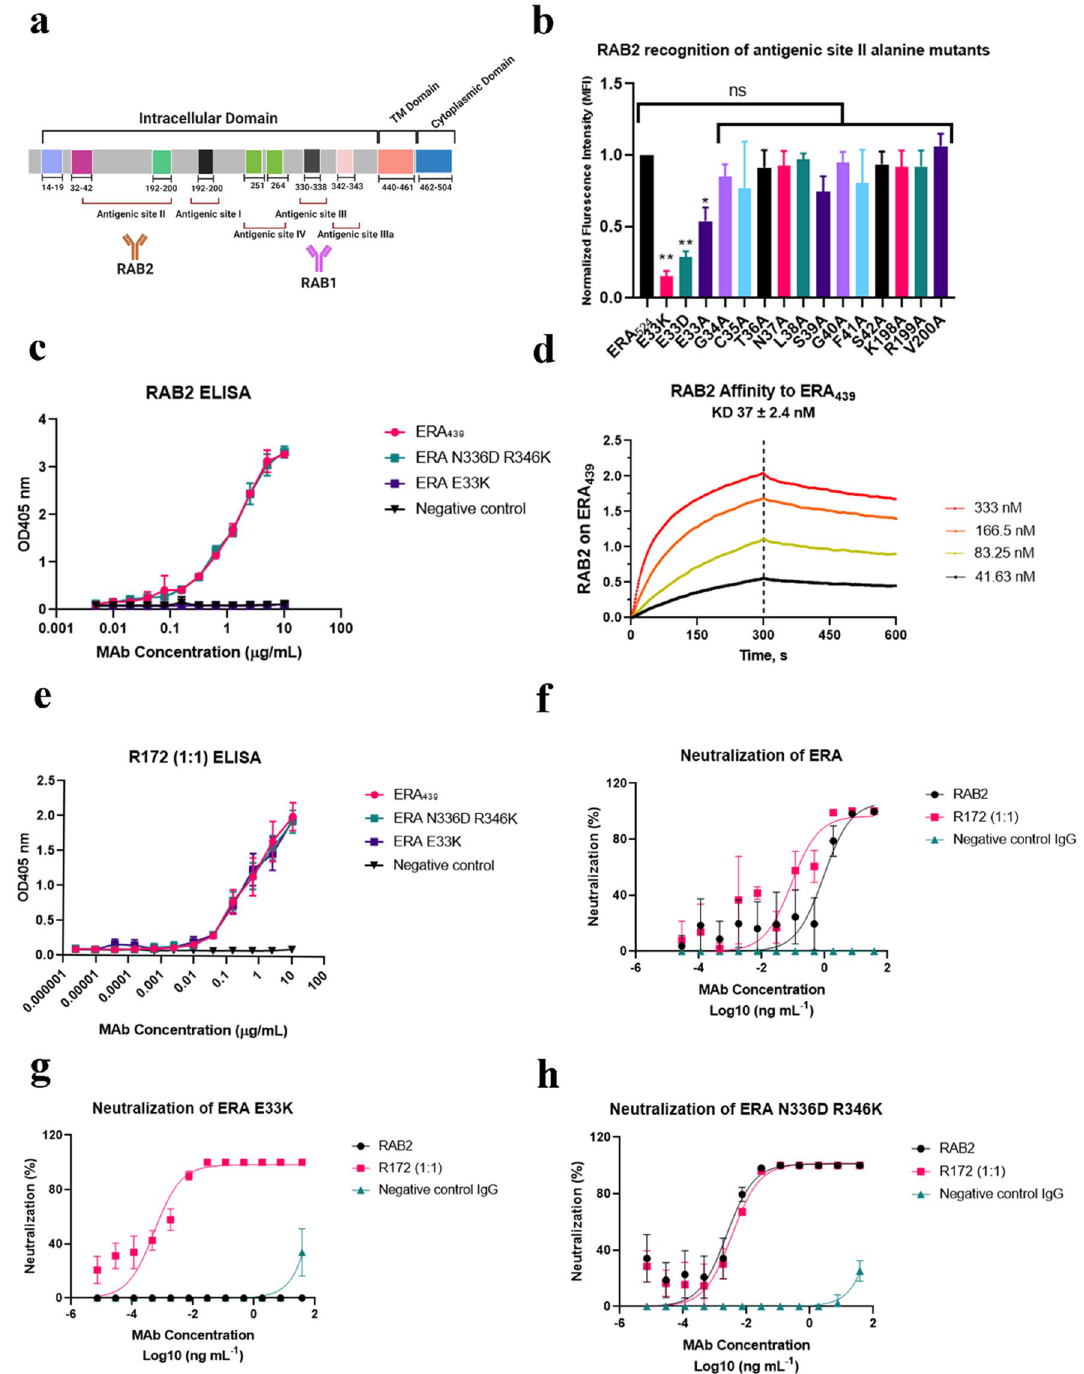
Figure 1. RAB2 and R172 binding and neutralization of rabies glycoproteins. ( a ) Schematic of rabies glycoprotein showing non-overlapping antigenic site locations of RAB1 (antigenic site III) and RAB2 (antigenic site II), figure was created with BioRender.com. ( b ) RAB2 recognition of antigenic site II alanine mutants. Each amino acid in the antigenic site II of ERA full length surface glycoprotein (a.a. 1–524) was substituted with alanine by site directed mutagenesis. ( c ) ELISA binding of RAB2 to the wild-type ERA439 or RAB1 escape N336D R346K and RAB2 escape E33K mutants. ( d ) Affinity measurement of RAB2 antibody against wild type ERA439, conducted by Bio-layer interferometry. ( e ) ELISA binding of R172 to the wild-type ERA439 or RAB1 escape N336D R346K and RAB2 escape E33K mutants. ( f – h ) R172 pseudovirus neutralization against lentivirus bearing the wild-type ERA glycoprotein ( f ), E33K ( g ) and N336D R346K ( h ) mutants. ERA glycoprotein was used as backbone to introduce all mutants. EC50 values were calculated by nonlinear regression analysis using Prism version 8.1.1. Data is plotted as the mean ± s.d. from n = 4 independent